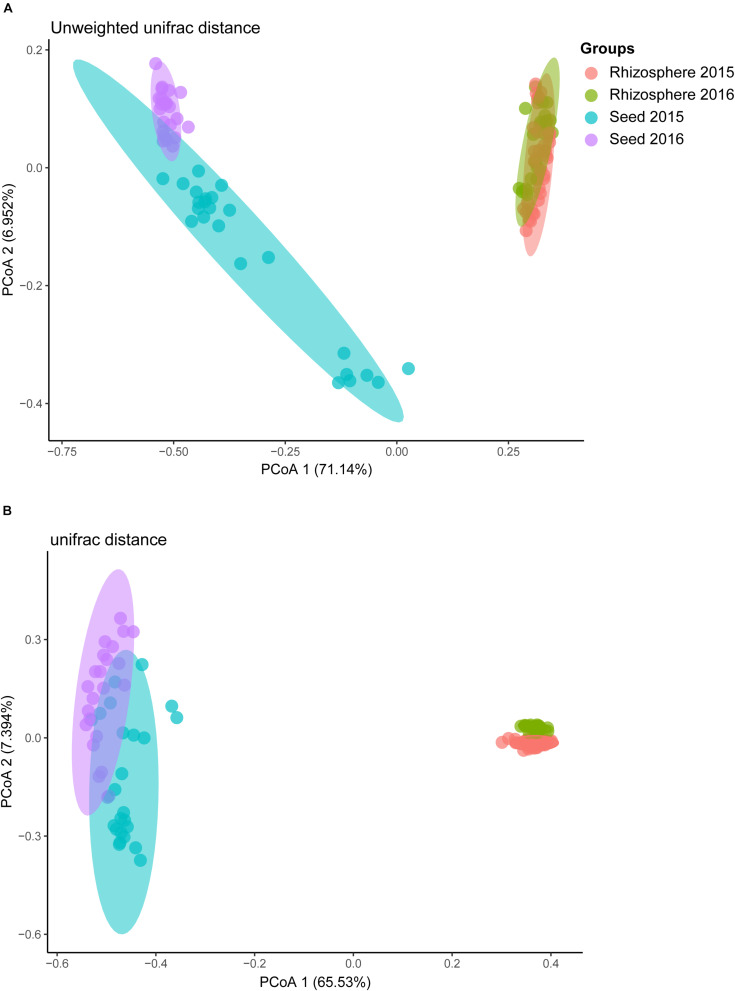
The principal co-ordinate analysis (PCoA) of rice bacterial communities based on (A) unweighted, and (B) weighted UniFrac distance dissimilarity.